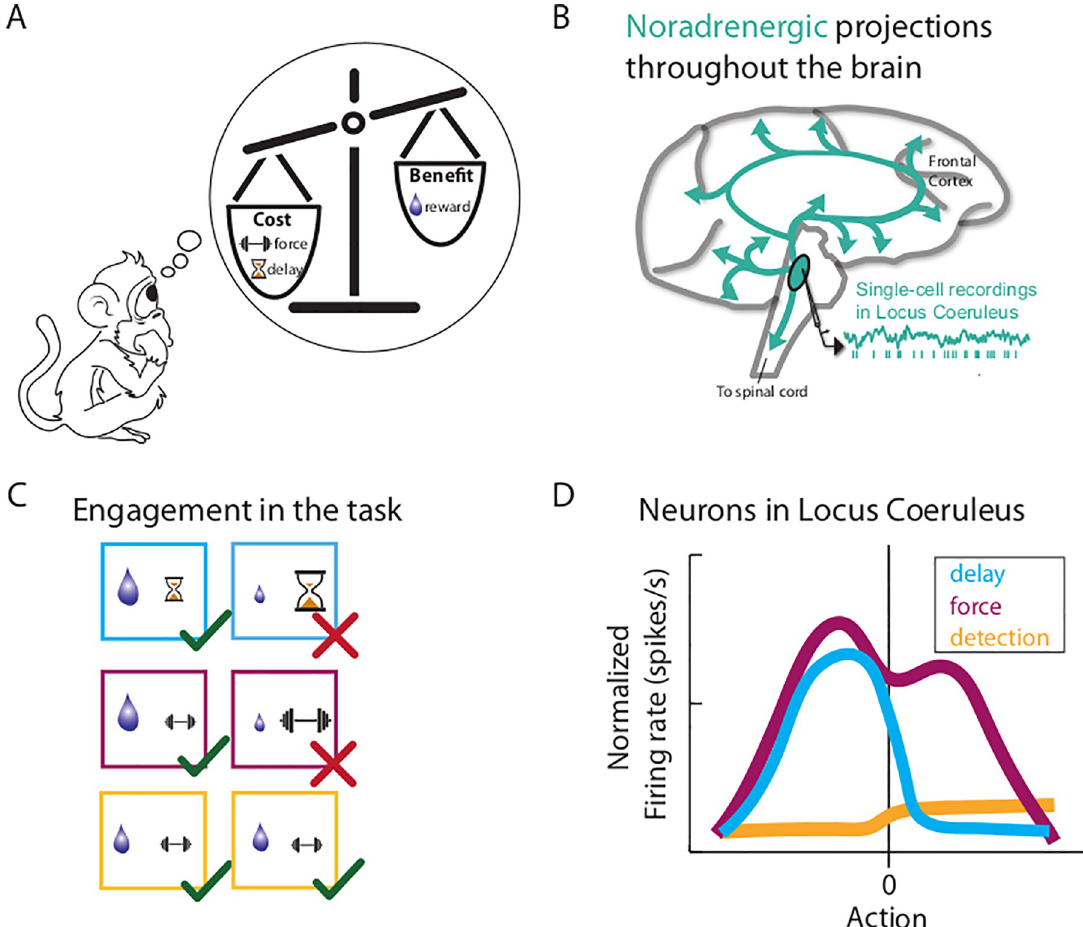
Fig 1. LC noradrenergic neurons encode effortful decisions. (A) Primates take decisions with the tendency to minimize costs while maximizing benefits. In the context of the experiment, costs involved either squeezing a grip more or less forcefully or waiting for more or less longer after releasing a lever while benefits involved different amounts of water. (B) Single-cell recordings were performed in the LC, a small nucleus in the brainstem that sends noradrenergic projections throughout the brain (in blue). (C) In 2 different tasks, the authors manipulated the level of physical effort animals had to exert on a grip (force, in purple) or the time delay after pressing a lever (delay, in blue) to earn various amounts of reward. In a third task (detection), animals had to apply a minimal force on a grip to receive a reward without any delay (in yellow). In the first 2 tasks, monkeys tended to avoid effortful options that entailed small amounts of reward, longer delays (in blue), or stronger physical forces (in purple), while in the detection task, there was no evidence for any bias. (D) The peristimulus time histogram symbolizes the mean firing rate of the population of LC neurons over time for the 3 tasks (delay, force, detection, in blue, purple, and yellow, respectively) aligned on the action onset. Right before the decision to act, LC neurons displayed a brief burst of activity only for the delay- and force-discounting tasks. Of note, the magnitude of this response was tightly related to the monkeys’ reaction time and reflected their willingness to perform the trial depending on its value and constraints. This activity was higher when the animal decided to engage in more demanding options (less reward, longer delay, or stronger grip) and was not modulated in the detection task. In addition, the activity also increased with more demanding physical effort in the force- discounting task. Together, these results suggest that the LC plays an important role in initiating and performing effortful actions. Given the widespread projections of the LC, these signals could be broadcasted toward other brain areas where increased NA availability could adjust sensory and cognitive processes to promote goal-directed behavior. L AU : AnabbreviationlisthasbeencompiledforthoseusedthroughoutFig 1 : Pleaseverifythatallentriesarecorrect : C, locus coeruleus; NA, noradrenaline.